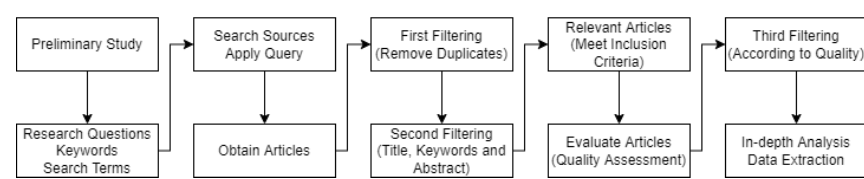
Figure 1. Systematic Literature Review Process